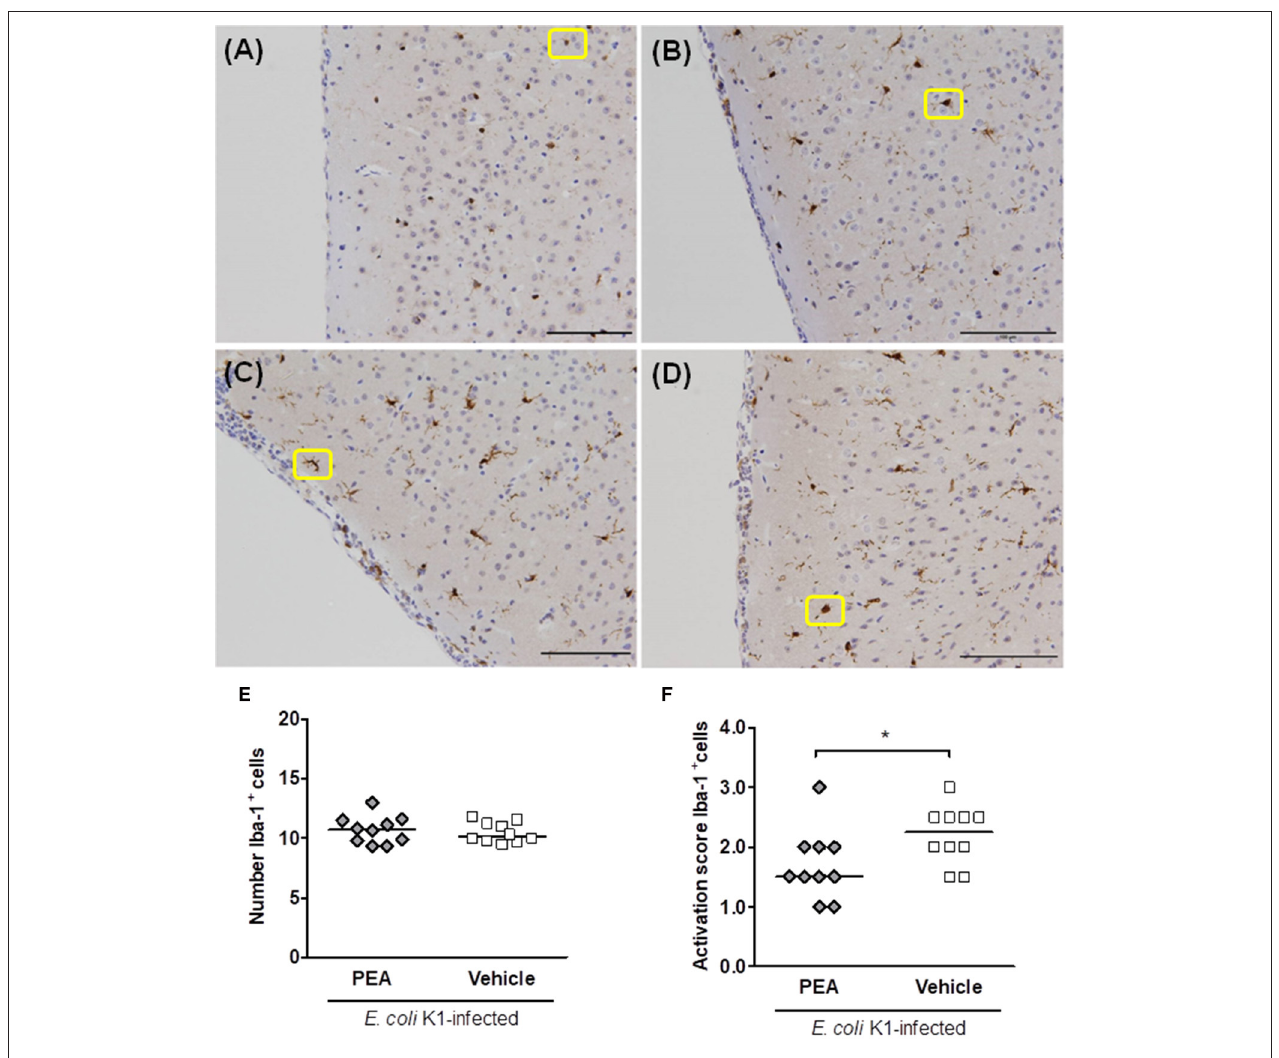
FIGURE 5 | PEA prophylaxis does not modify microglial density, but attenuates microglial activation in aged infected mice. (A–D) Illustrative examples of the different cell morphologies (circled in yellow) and the corresponding activation scores in neocortex. A single activation score (AS) was given by a blinded investigator according to the most abundant cell morphology for each analyzed region: (A) microglia with small size and very fine ramifications (AS 1), (B) hypertrophic with thicker branches (AS 2), (C) bushy (AS 3), and (D) ameboid (AS 4); scale bars, 100 µ m (magnification, × 20). (E) Number of Iba-1 + cells in brains of PEA- and vehicle-treated aged mice sacrificed 24h after infection. (F) AS of Iba-1 + cells in brains from the same PEA- and vehicle-treated aged mice. In (E,F) , each symbol represents an individual mouse and bars indicate medians. * P < 0.05, using the Mann–Whitney U